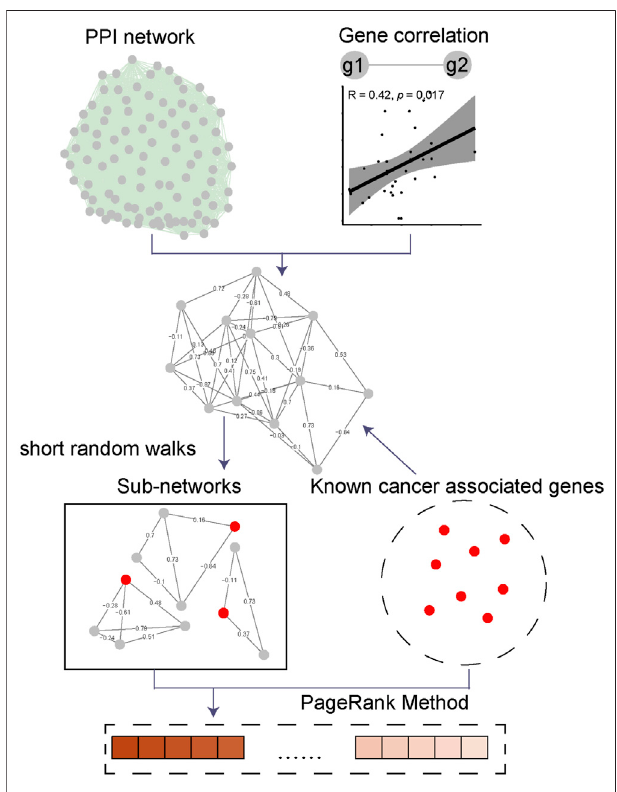
FIGURE1| FlowchartofPRNet.Theproteininteractioninformationfrom validatedPPIdatabases.Genepairs ’ expressioncorrelationwascalculatedby using TCGA PAAD mRNA expression matrix. Thesedatasets were merged to construct a standard PAAD-speci fi c weighted-PPI network. Short random walks algorithm was used to slice this extensive network into multiple communities, and kept only the communities containing known CAGs as disease-speci fi c sub-networks. Finally, the PageRank algorithm was applied to analyze the fi nal constructed network and calculated the PR value of each